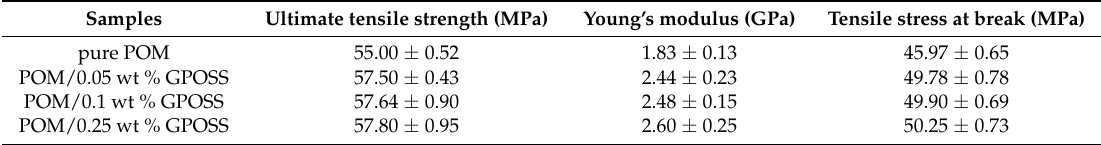
Table 3. Mechanical properties, with standard deviations, of pure POM and POM/GPOSS composites.